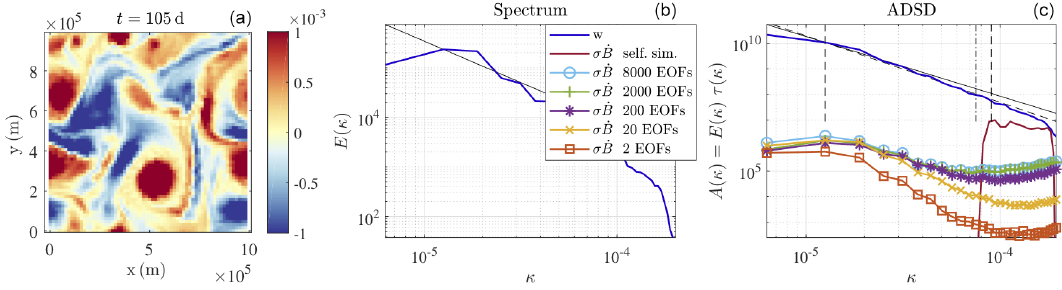
Figure 7. Buoyancy field (ms − 2 ) (a) , kinetic energy spectrum (m 2 s − 2 / (radm − 1 )) (b) , and ADSD (m 2 s − 1 / (radm − 1 )) (c) of w , at t = 105d, ADSD of σ ˙ B from the non-data-driven method (without a multiplicative constant); ADSD of σ ˙ B from the data-driven method, with (b) ; and a corresponding ADSD (c) in a black solid line. The two dashed vertical lines 2, 20, 200, 2000, and 8000 EOFs, and a slope of − 5 3 define the interval where coefficients C w and r w are fitted. The dashed oblique line is the resulting fit (it is set to match A w in the left bound of the interval).